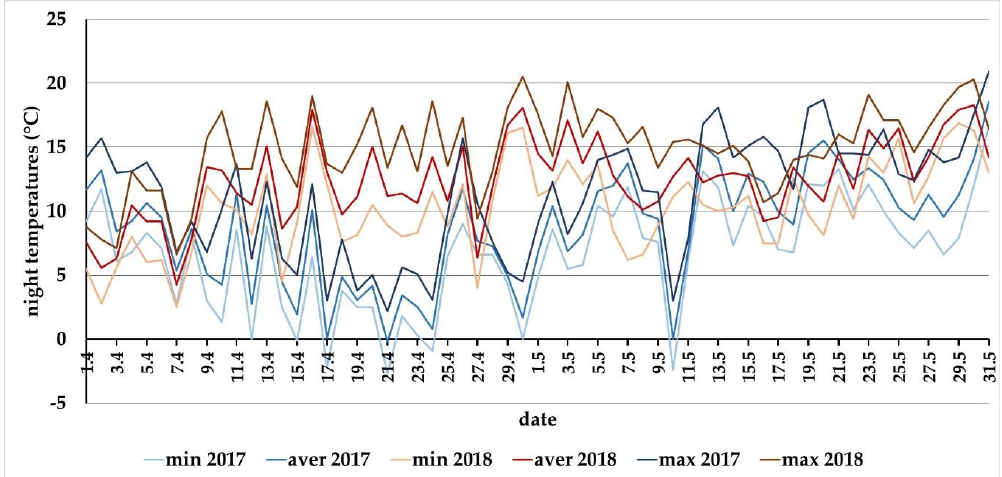
Figure A2. The night temperatures (20:00–05:00) through April and May in 2017 and 2018 at the locality of B á b (southwestern